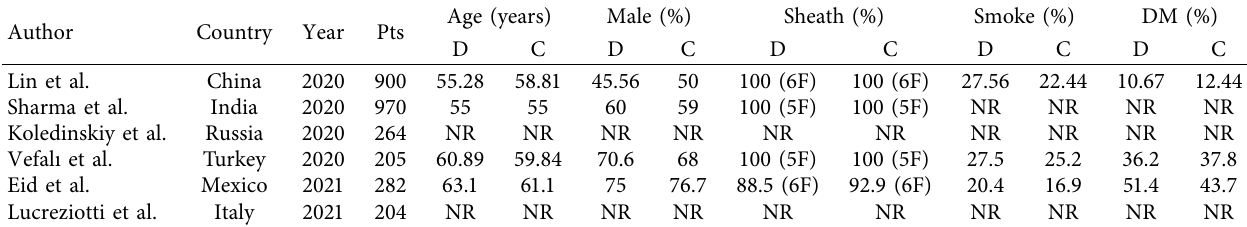
Table 1: General characteristics of the reviewed studies included in the final analysis.